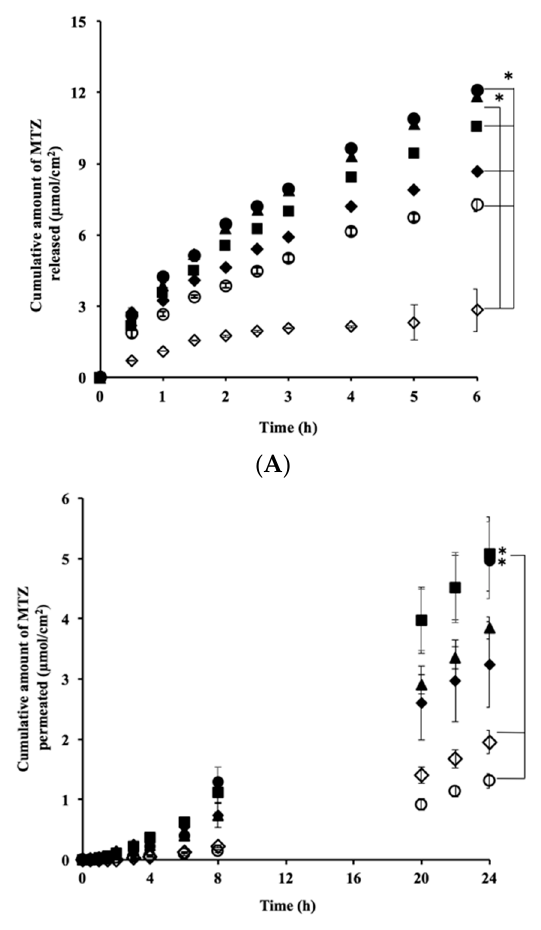
Figure 2. Permeation profiles of metronidazole (MTZ) through the excised hairless rat skin from its aqueous solution with or without a chemical enhancer. MTZ permeation was significantly (* p < 0.05) improved by isopropyl myristate (IPM) when compared with the aqueous solution without an enhancer (control) and other chemical penetration enhancers (CPEs). Symbols: : aqueous solution,